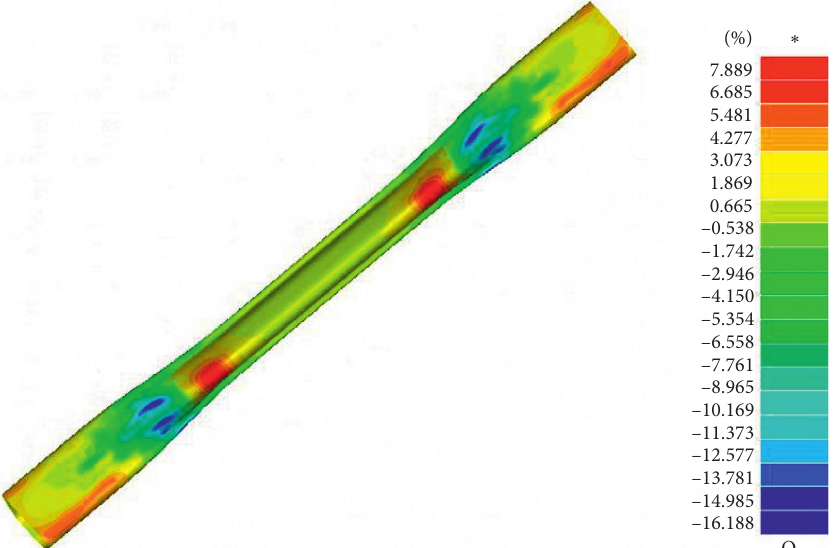
Figure 13: Nephogram of torsion beam wall thinning